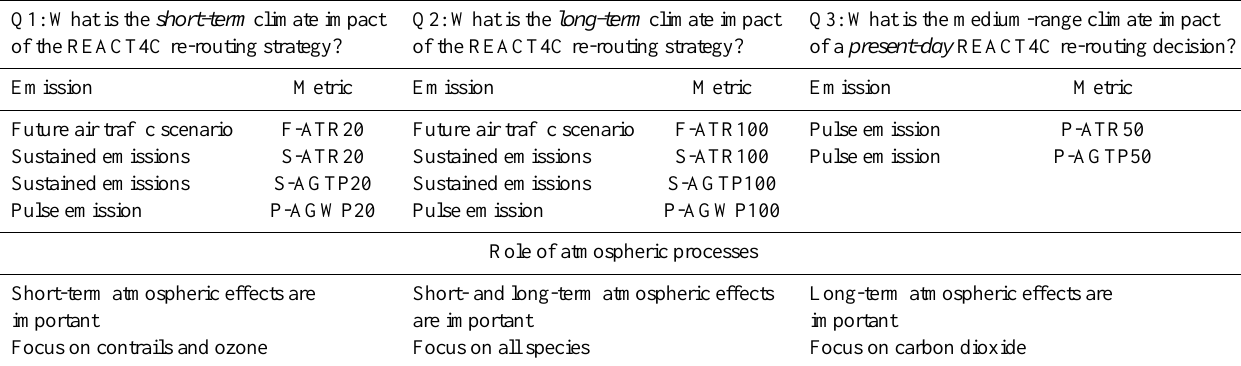
Table 7. Overview of objectives and implied emission scenarios and climate metrics or indicators. “F”, “S” and “P” indicate assumptions on emissions: future emission scenario, sustained emissions and pulse emissions, respectively. ATR is the average temperature response, AGTP the absolute global temperature potential, and AGWP the absolute global warming potential; the number after the metrics gives the time horizon in